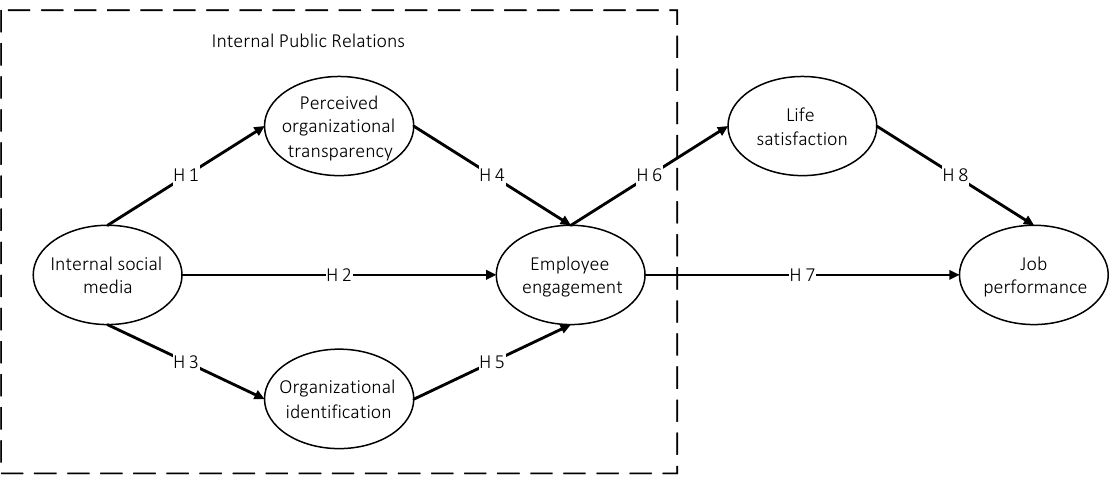
Figure 1. Conceptual